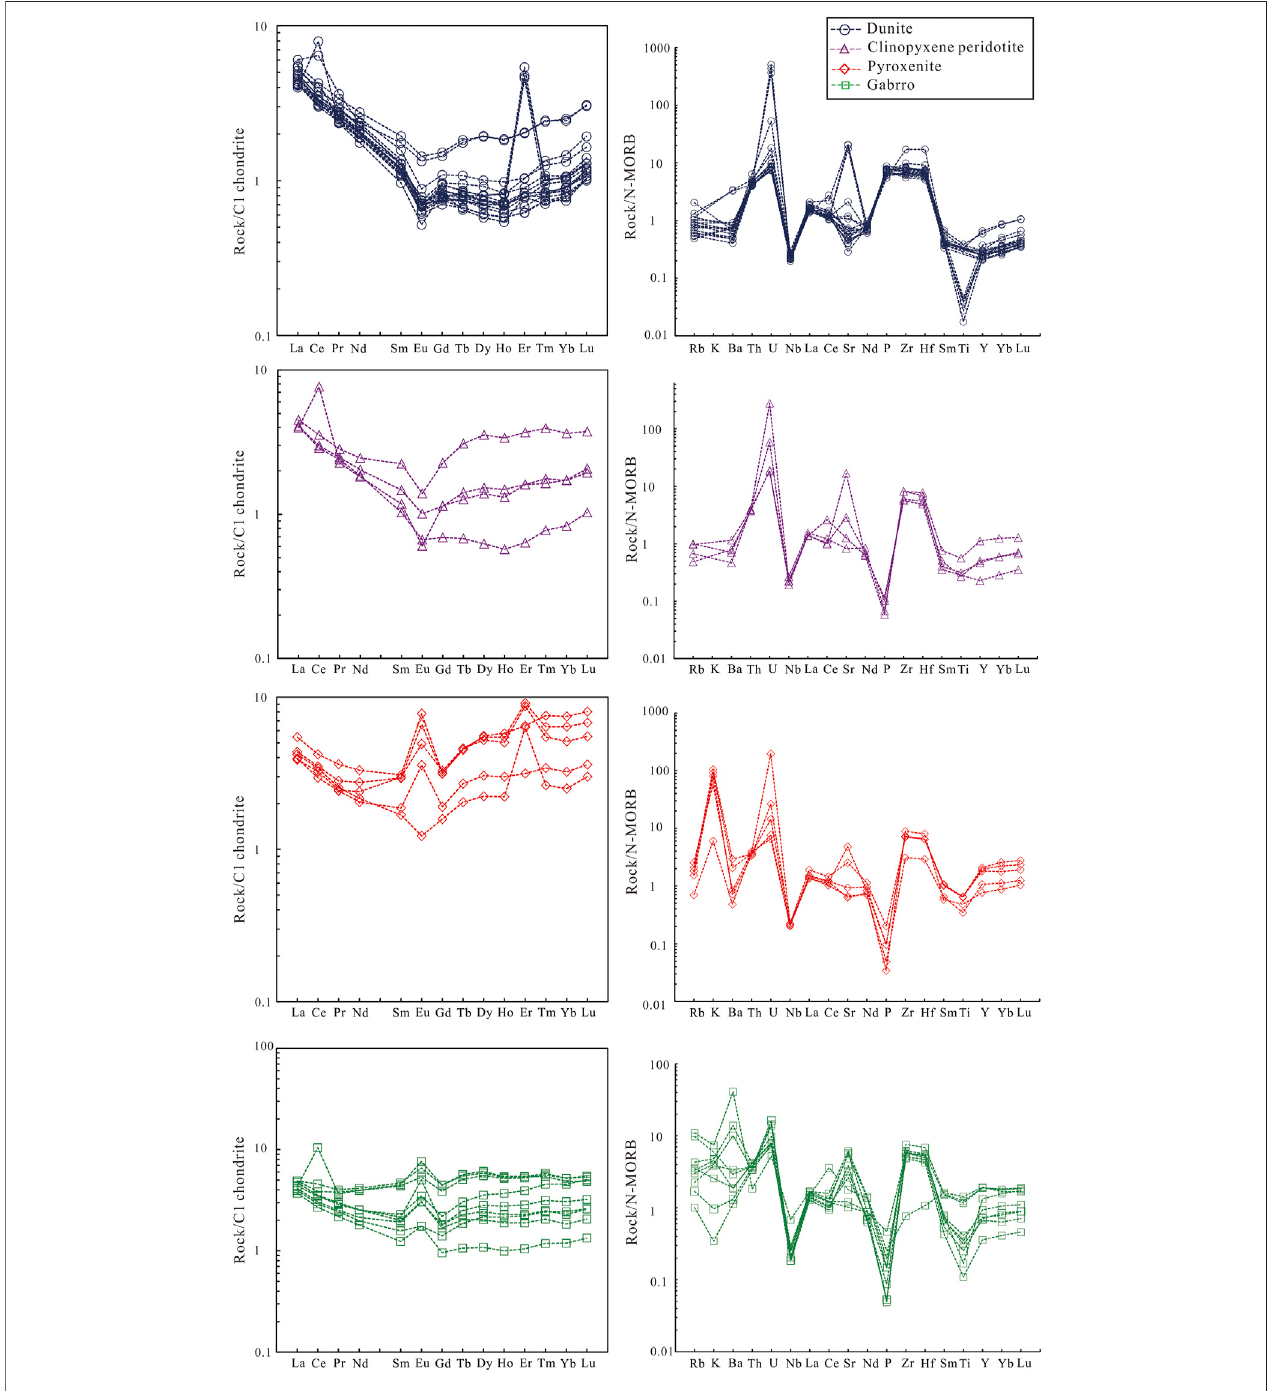
FIGURE 7 | N-MORB normalized spider diagrams and C1 chondrite-normalized REE patterns of the Hongshishan complex. C1 chondrite-normalizing values are from Sun and McDonough (Sun et al., 1989), primitive mantle-normalizing values are from McDonougha and Sun (McDonough and Sun., 1995).